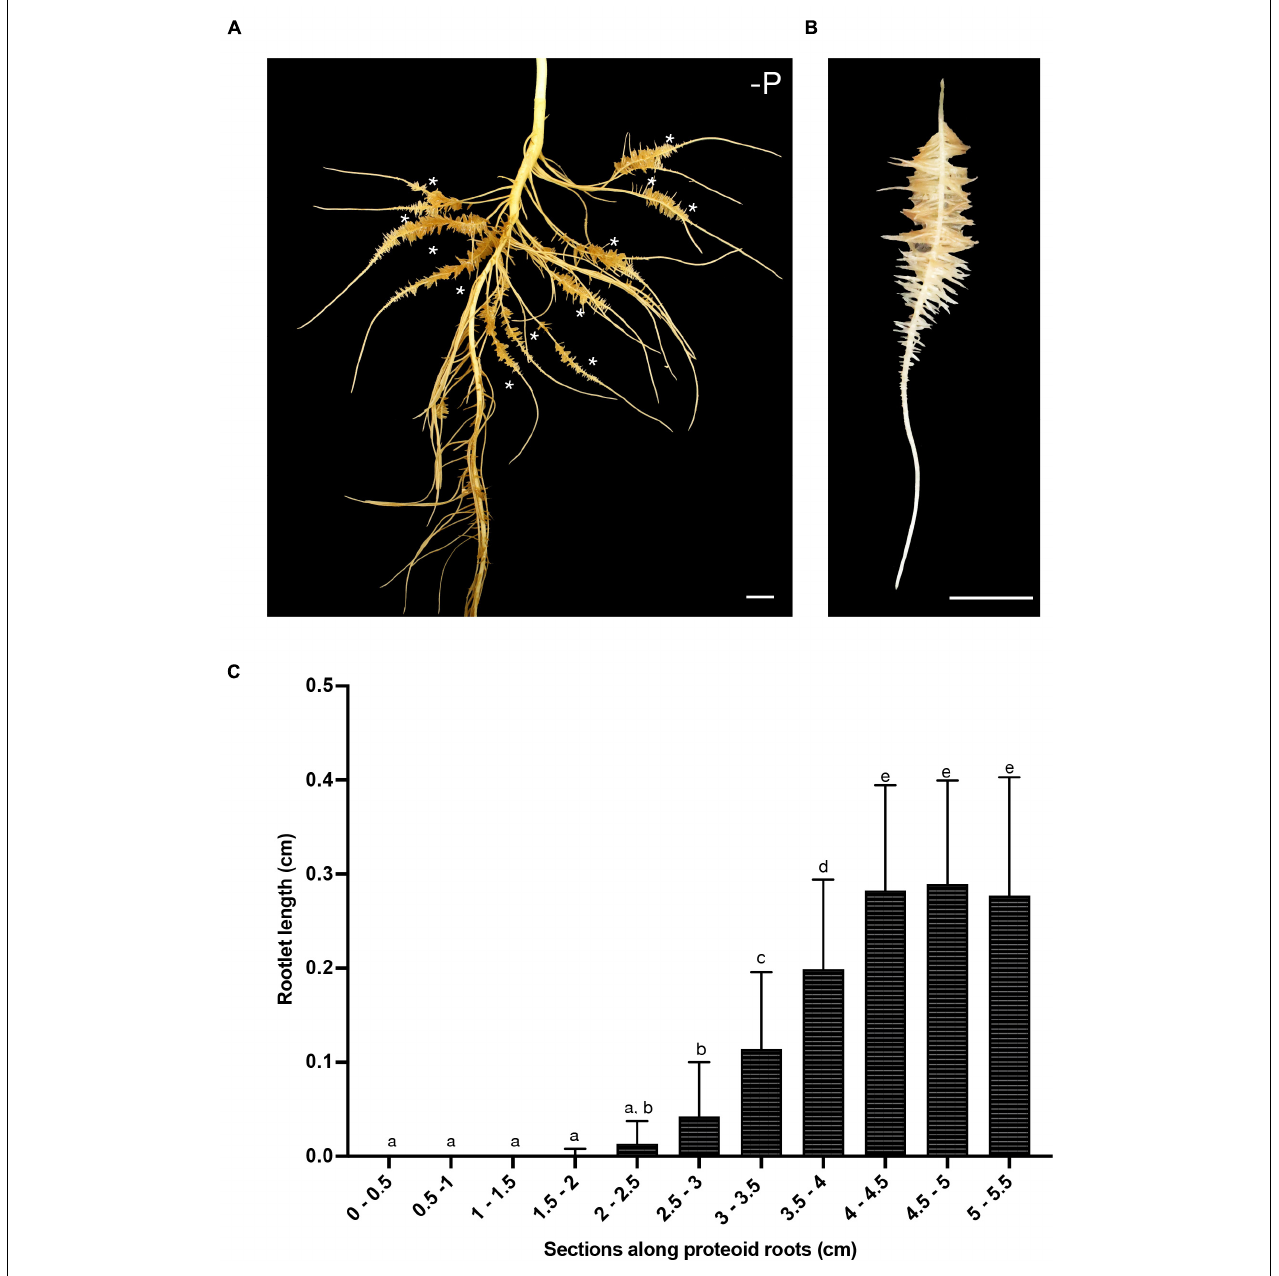
FIGURE 1 | White lupin root system architecture. (A) Root system of a 16-days-old white lupin hydroponically grown in Pi deficiency conditions resulting in the development of several cluster roots each bearing a single cluster of rootlets (*). (B) A typical 7 cm-long cluster root displaying one cluster of rootlets. (C) Measurement of rootlet length: 5 rootlets were measured in 0.5 cm sections from the tip of the root to the end of the cluster ( n = 21). Scale bars: (A–B) 1